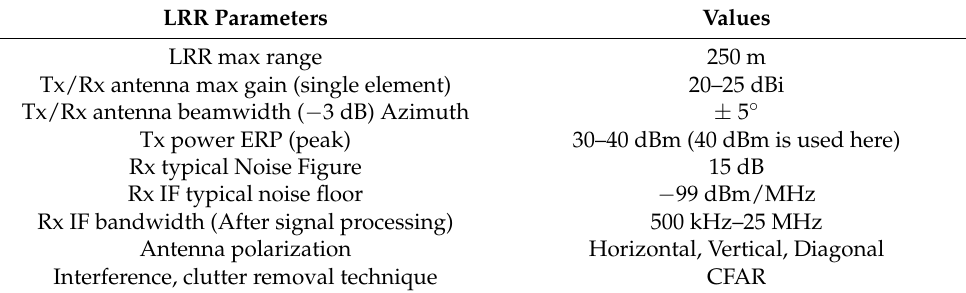
Table 1. LRR parameters